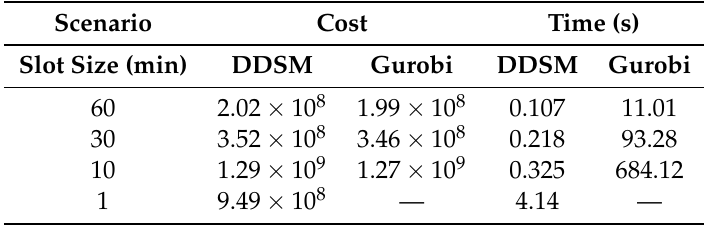
Figure 7. Evaluation of Algorithm 2 with different update sequences of users’ appliance scheduling and power management strategies. Table 6. Performance comparison of different slot